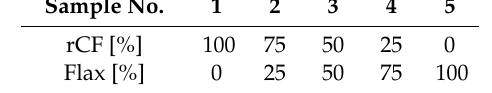
Table 1. Fibre volume ratio of recycled carbon fibres (rCF) and flax for each sample. Sample No.